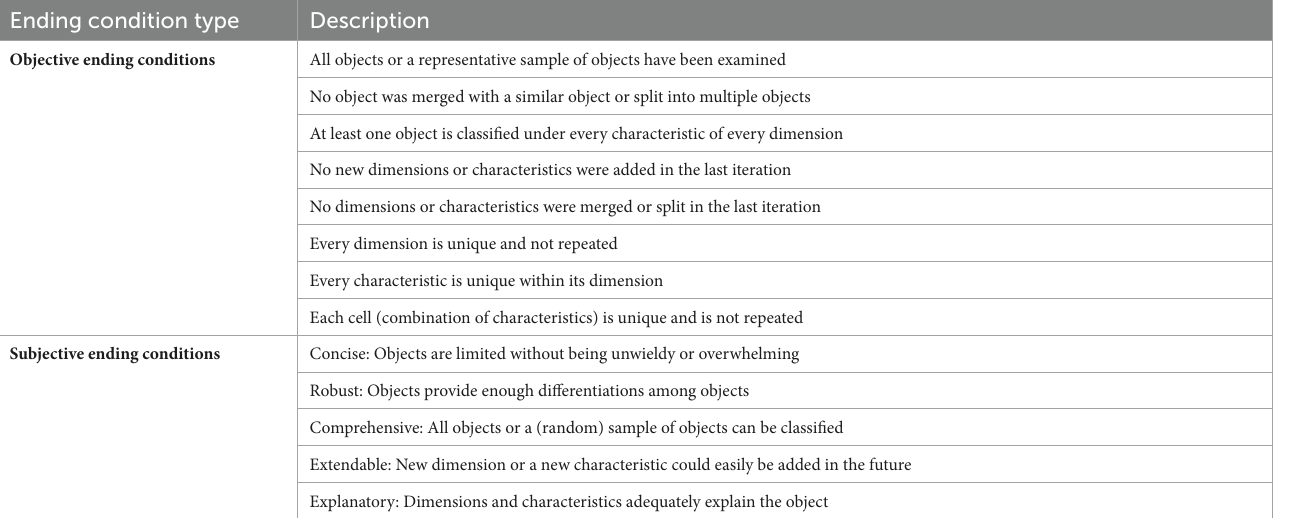
TABLE 4 Ending conditions for taxonomy development (adapted from Nickerson et al., 2013, p: 344). Ending condition